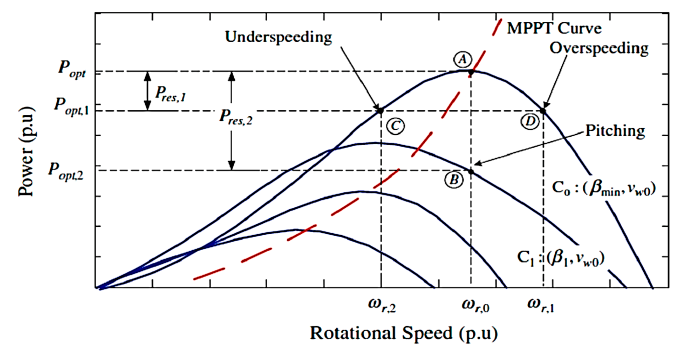
Figure 9. Different de ‐ loading options and maximum power tracking curve.